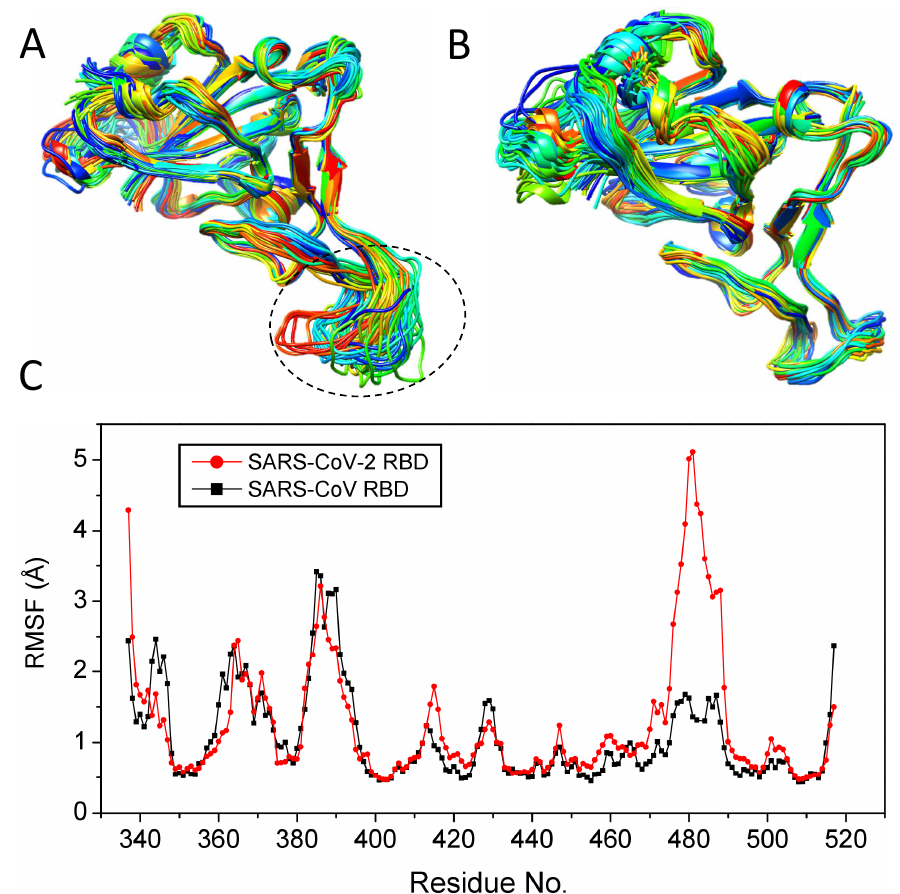
Figure 3. The conformational flexibility of the RBD protein. ( A ) The 50 representative trajectories of the SARS-CoV-2 RBD protein over a 10 ns MD simulation, where the highly flexible region (residues 470–490) is indicated by a circle. ( B ) The 50 representative trajectories of the SARS-CoV RBD protein over a 10 ns MD simulation. ( C ) The RMSFs for the RBD proteins of SARS-CoV-2 and SARS-CoV, where the residue numbering is taken from the SARS-CoV-2 RBD and the data of SARS-CoV are then aligned to those of SARS-CoV-2 according to the sequence alignment. 19